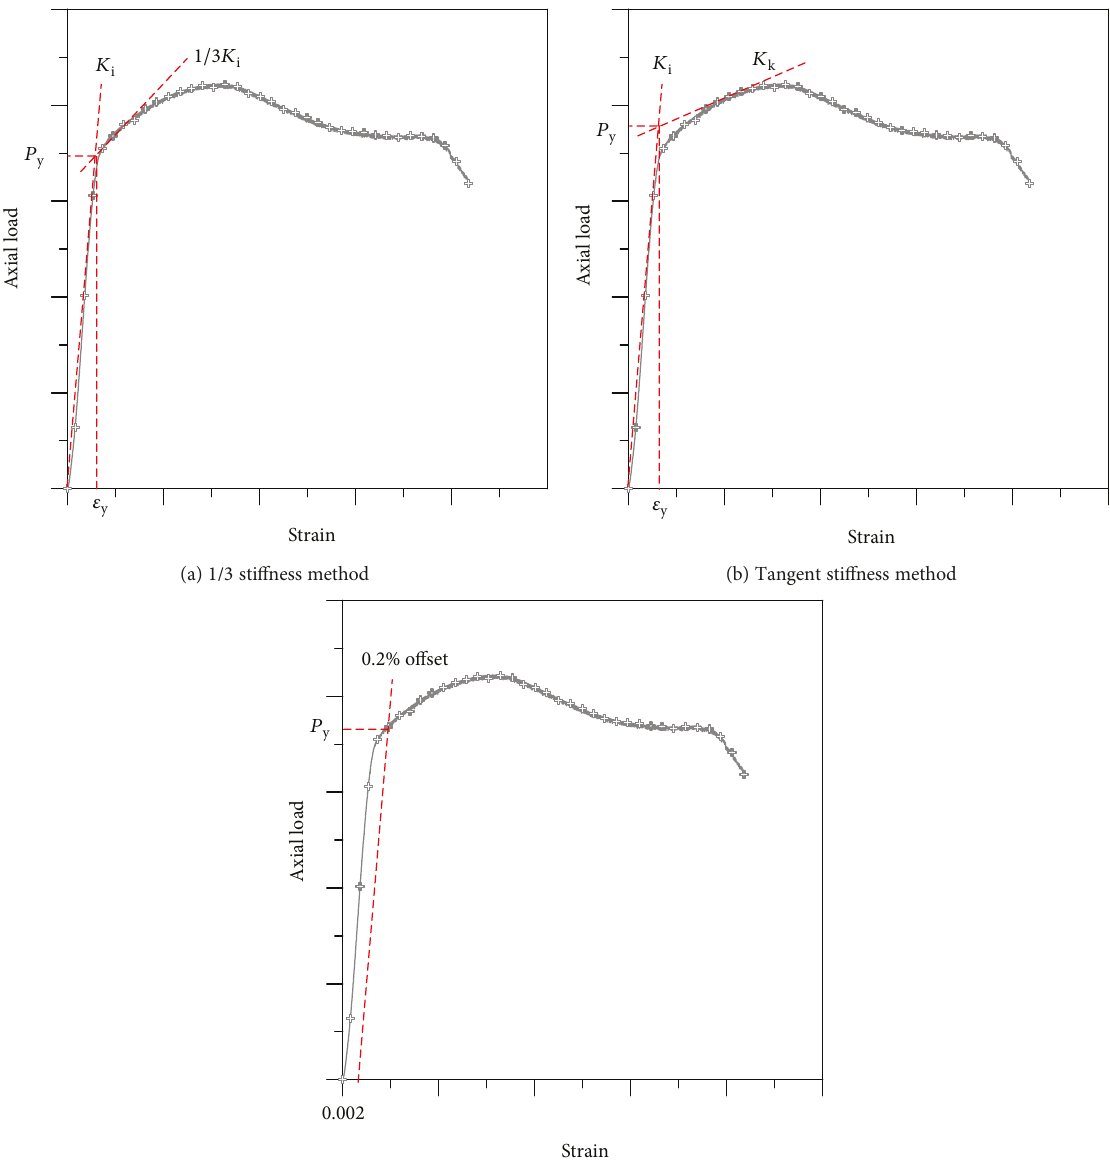
Figure 7: Determination method for yield strength of